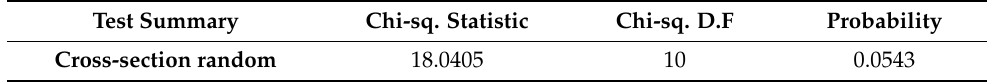
Table 1. Correlated Random Effect Hausman